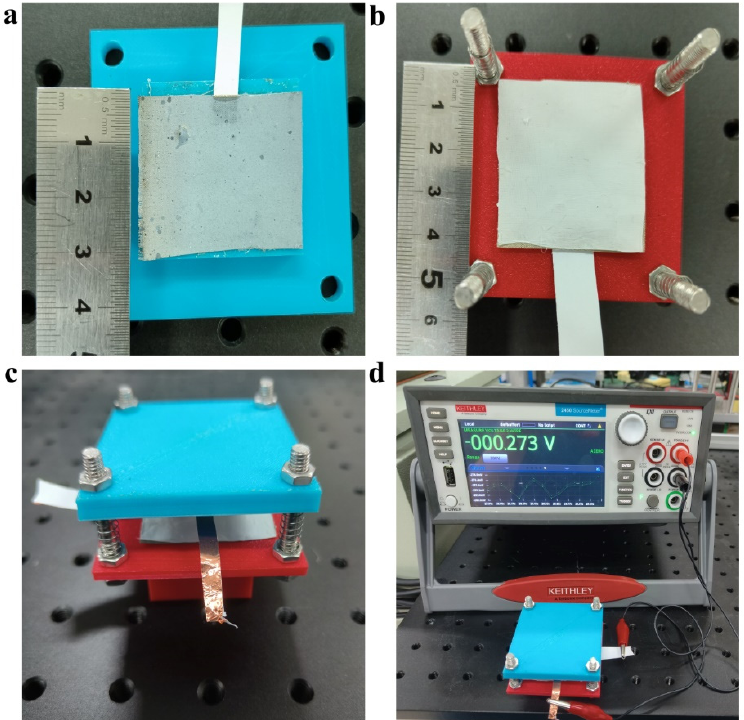
Figure 4. Testing flow diagram of the contact-separated TENGs. ( a ) PA66/graphene pasted on the upper plate; ( b ) PVDF film pasted on the bottom plate; ( c ) installation diagram after assembly; ( d ) signal testing diagram.